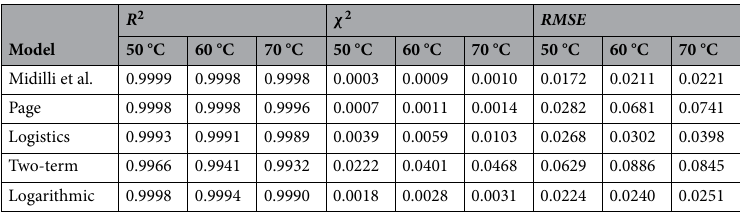
Table 2. The statistical comparison for prediction drying of apple slices in CD dryer.